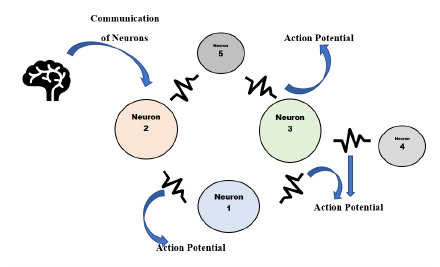
Figure 2. Communication of Neuron. Neuron pass the informations in the form of action pontential to another